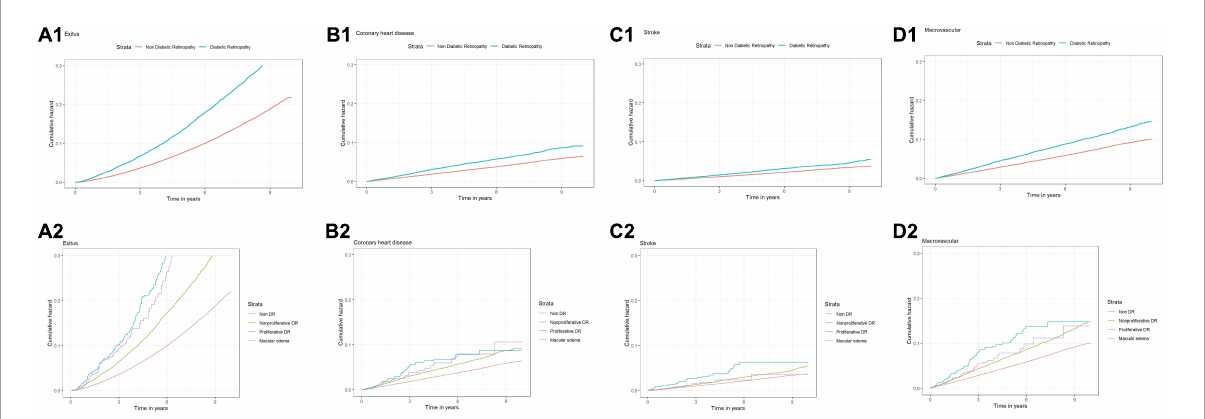
FIGURE2 Survival curves and different study events and stages of diabetic retinopathy. (A1) All-cause mortality; (B1) coronary heart disease; (C1) stroke; (D1) macrovascular complications; (A2) all-cause mortality and different states of DR; (B2) coronary heart disease and different states of DR; (C2) stroke and different states of DR; (D2) and different states of DR and different states of